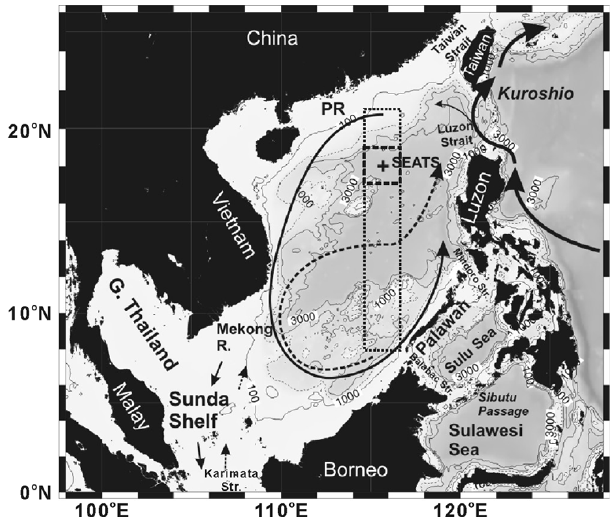
Fig. 1. The South China Sea bathymetry and location of the SEATS station. The dotted square indicates the 2 ◦ × 2 ◦ study area centred at the SEATS station (See